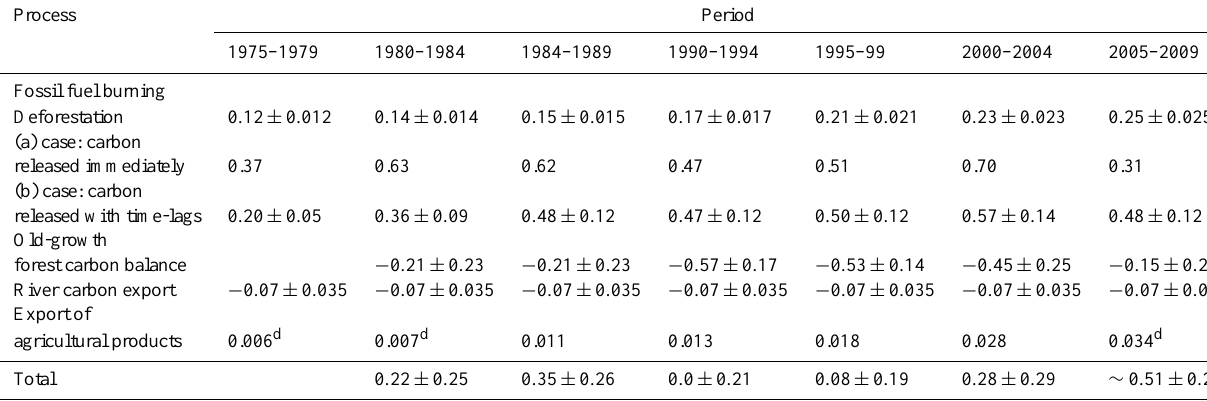
Table 12. Summary of carbon flux estimates (PgCyr − 1 ) and carbon balance of South America a .